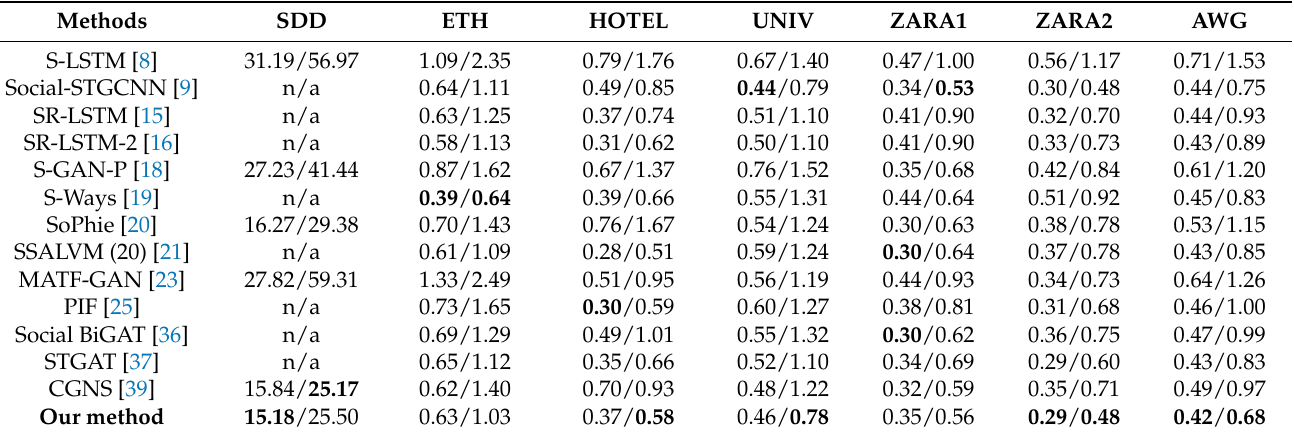
Table 2. Quantitative results of state-of-the-art methods for ETH, UCY, and SDD datasets in terms of ADE/FDE metrics. All models use eight frames as input and predict the next twelve frames. The column AWG represents the average results between the ETH-UCY datasets’ scenes. n/a means that the corresponding articles have not provided detailed results in the SDD